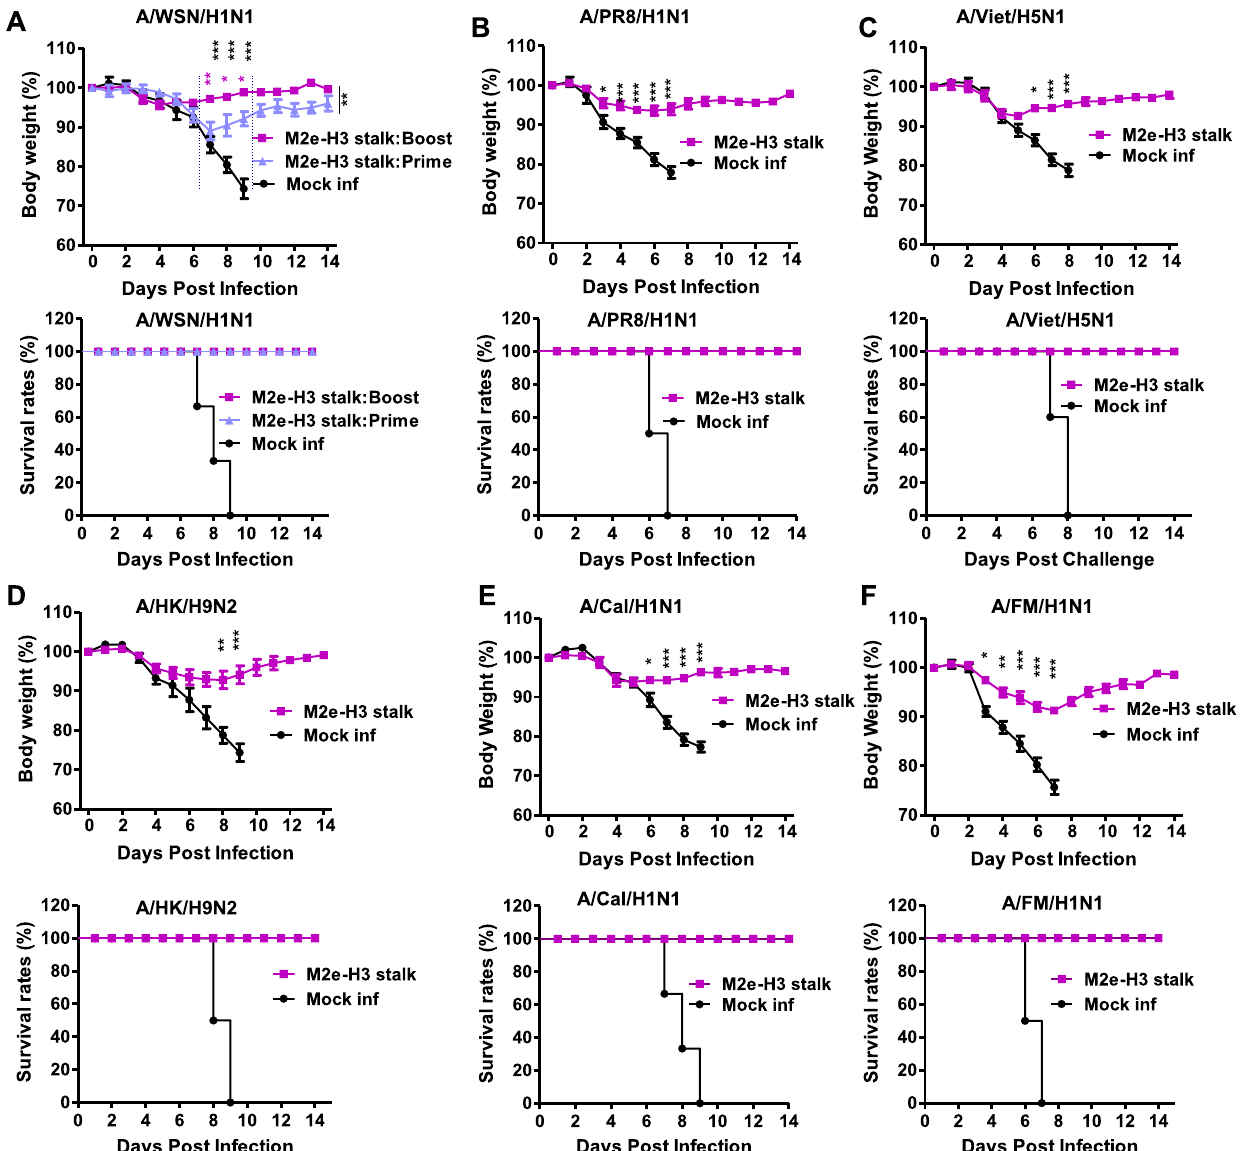
Fig. 5 Adjuvanted M2e-H3 stalk protein provides protection against heterologous cross-group 1 in fl uenza A viruses. The groups of mice ( n = 5, 6 – 8 weeks old) vaccinated with adjuvanted M2e-H3 stalk (prime and prime-boost for WSN/H1N1 virus challenge group or prime-boost for the rest of virus challenge) were intranasally challenged with group 1 in fl uenza A viruses (H1N1, H5N1, H9N2). Body weight changes and survival rates were monitored for 14 days. A A/WSN/1933 H1N1 (2xLD 50 , 1.5 × 10 2 EID 50 ), B A/PR8/1934 H1N1(4xLD 50, 1.2 × 10 3 EID 50 ), C A/Viet/ 2004 rgH5N1 (3xLD 50 , 2.6 × 10 4 EID 50 ), D A/HK/1999 H9N2 (4xLD 50 , 7.8 × 10 1 EID 50 ), E A/Cal/2009 H1N1(3xLD 50 , 2 × 10 3 EID 50 ), F A/FM/1947